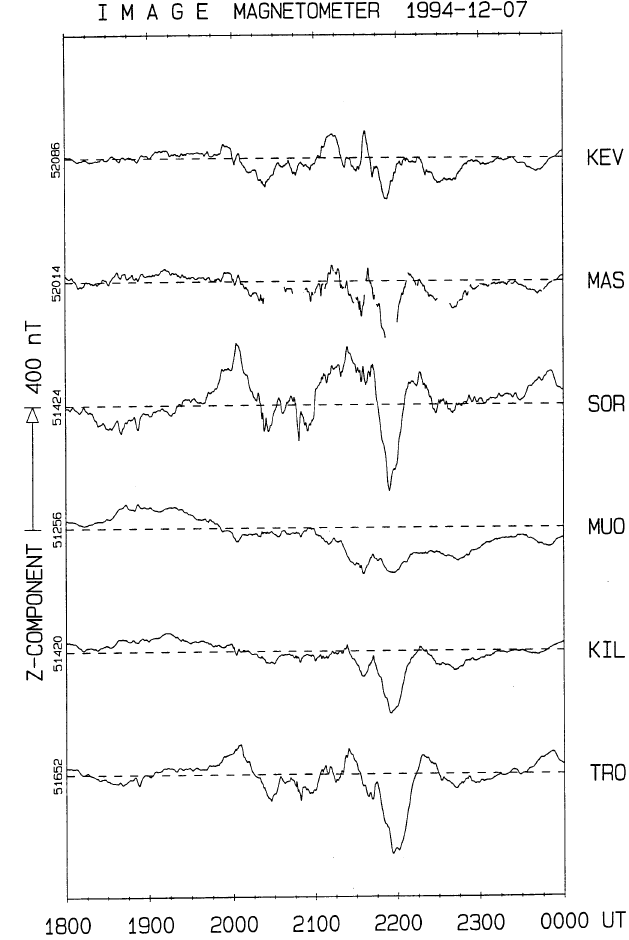
Fig. 1. Northward horizontal component of the ground-mag- netometer disturbances at different IMAGE magnetometer chain